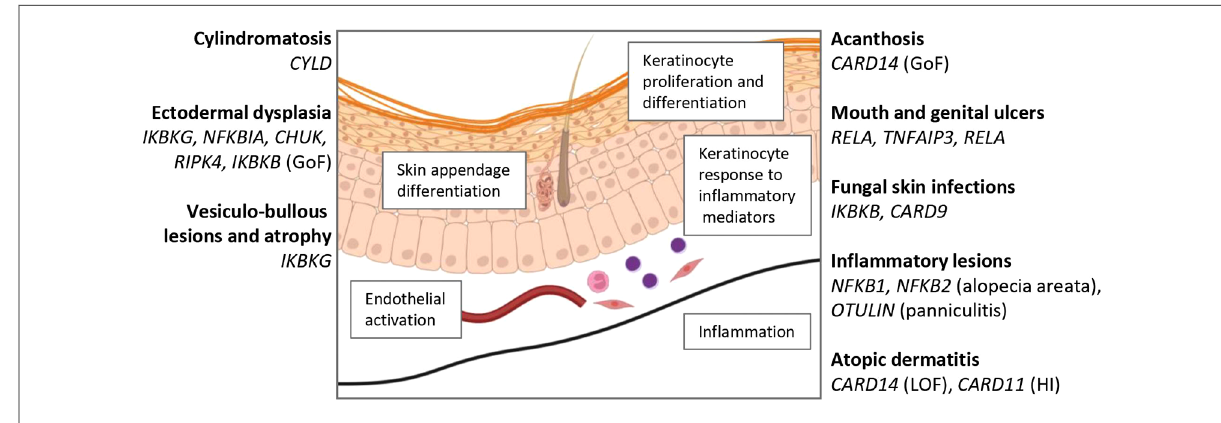
FIGURE 2 Summary of skin pathology associated with defects in NF- κ B. Created with